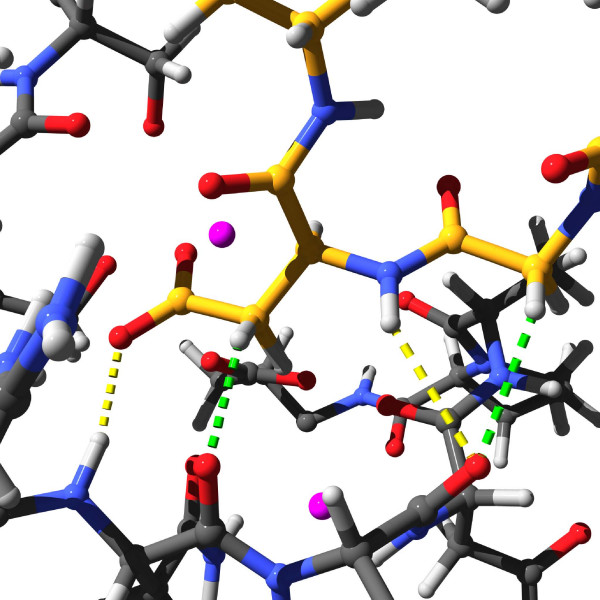
An array of four hydrogen bonds, two N-H···O=C (in yellow) and two C-H···O=C (in green), line up the bottom of the cRGD peptide against the integrin surface. The two weak Cα/β-H···O=C interactions thus contribute to the specificity of binding and presumably also have a cooperative effect on stability. Colour scheme for atom types as in Figure 2.